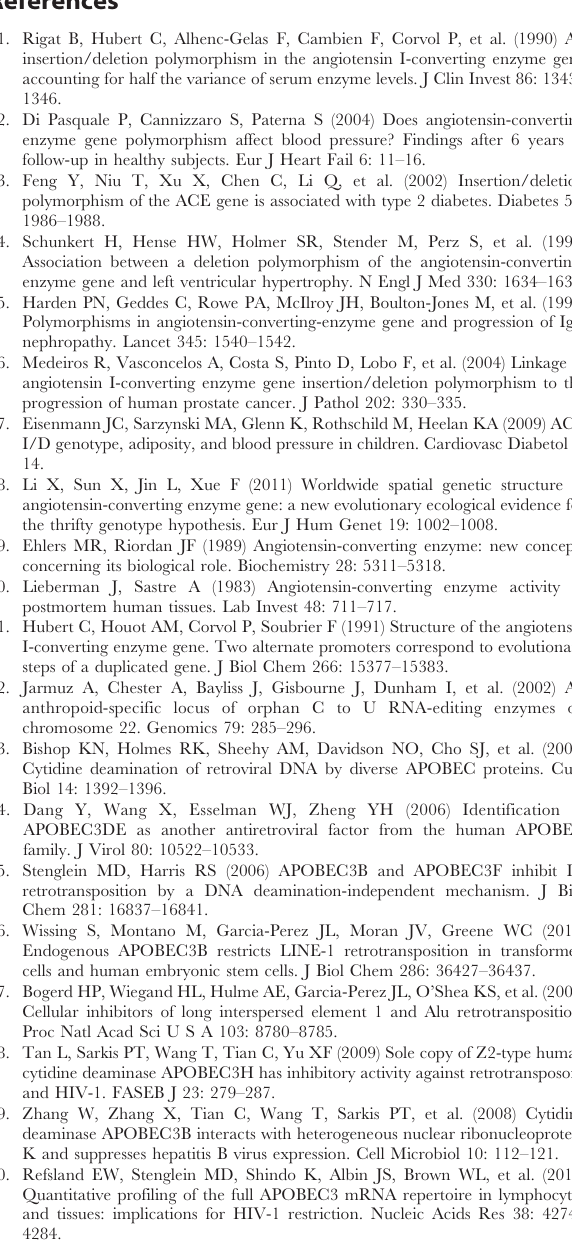
Table S3 Characteristics of male subjects grouped by ACE and A3B genotypes. Table S4 Characteristics of female subjects grouped by ACE and A3B genotypes. Table S5 Characteristics of male subjects grouped by ACE genotypes. Table S6 Characteristics of female subjects grouped by ACE